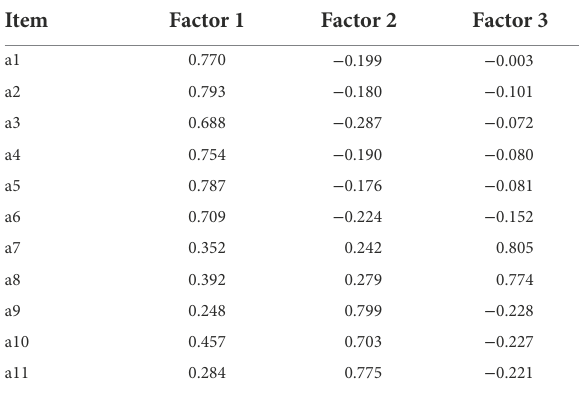
TABLE 5 Factor loadings of exploratory factor analysis for the Chinese version of the ATREND